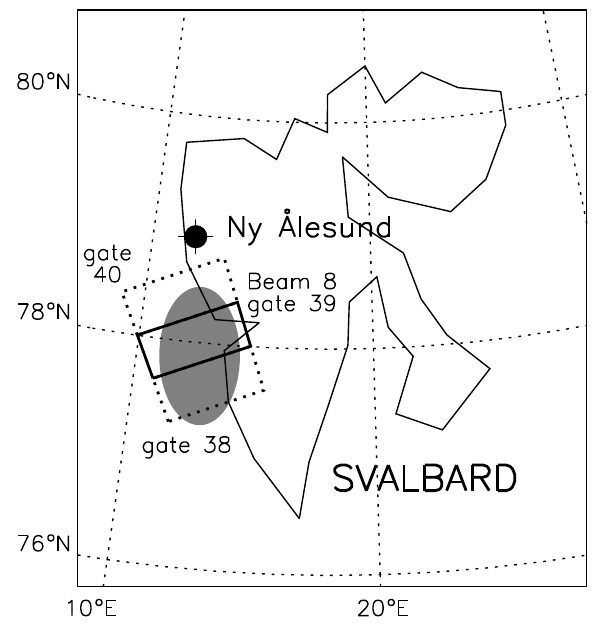
Fig. 2. (a) A map of Svalbard, showing the ground station at Ny ˚Alesund, the ionospheric intersection point of the scintillation mea- surements (grey ellipse), and the locations of gates 38, 39, and 40 of beam 8 the Finland radar.